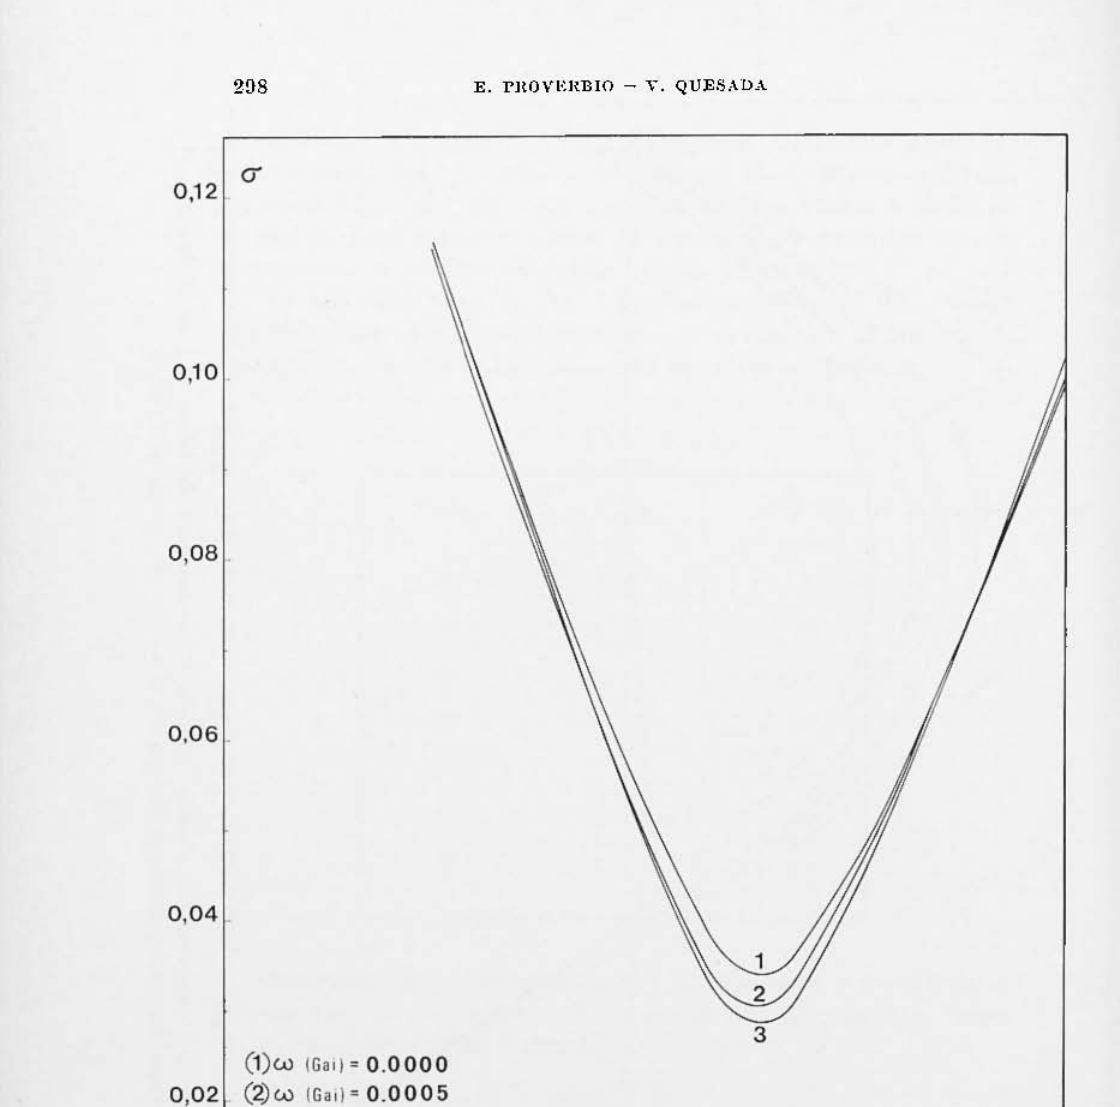
Fig. 4. - niflgram of the cm·ves of siamlanl devifltion ('aleulatc(l by kceping thc pamlllctcr <P~ = 82 0 {·onstant am] varying thc valnes or ili" as appears from Tablc